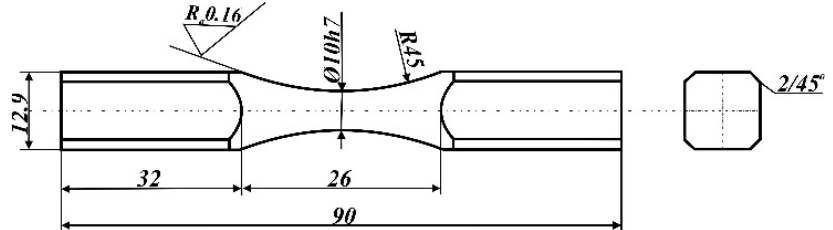
Figure 2. Test specimen used for fatigue strength tests.